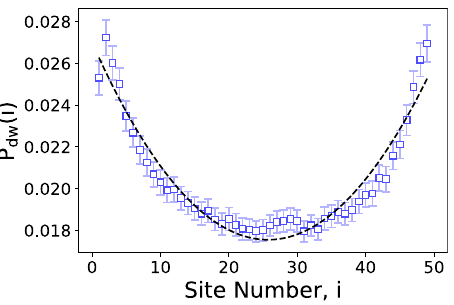
Fig. 4 Domain-wall distribution for a 50-qubit chain using the same experimental setup as Fig. 3 (including background susceptibility corrections). Dashed line is a parabolic fi t. Error bars represent standard error.